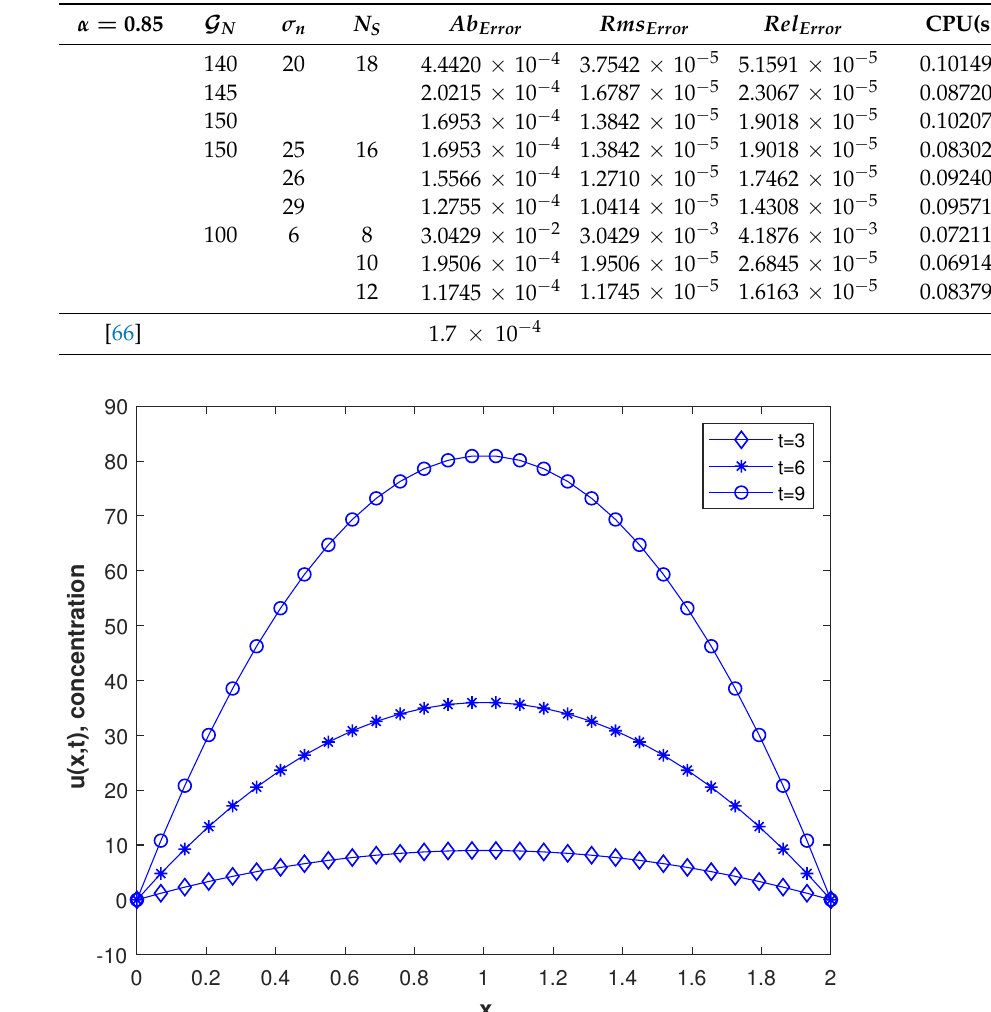
Table 1. The errors obtained using the proposed numerical scheme at final time T = 1 corresponding to problem 1.